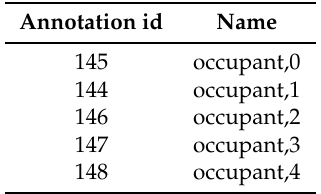
Table 5. Annotations used for the ground truth about the number of occupants for the person counting data set.